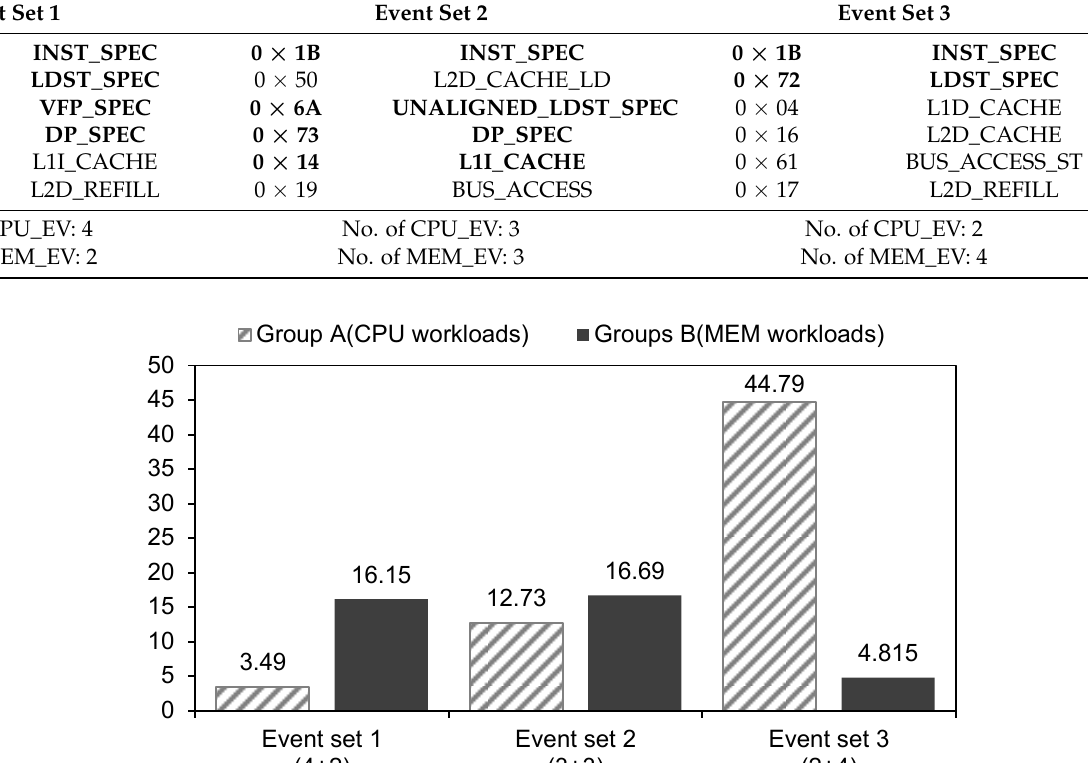
5 of 19 Table 2. Three event sets used in motivational studies. Event Set 1